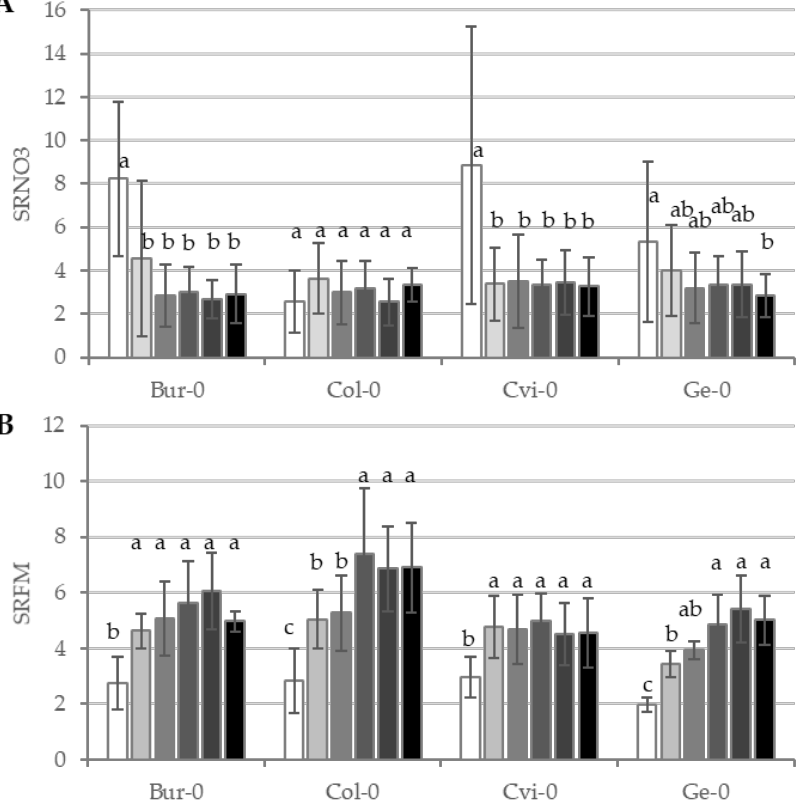
Figure 4. Genotype by nutrition interaction on trait variation. Shoot-to-root NO 3 content ratio (( A )-SRNO 3 ) and shoot-to-root fresh matter ratio (( B )-SRFM). The six different NO 3 supplies are reported in bars of different shades of grey. Different letters indicate values significantly different at p < 0.05.